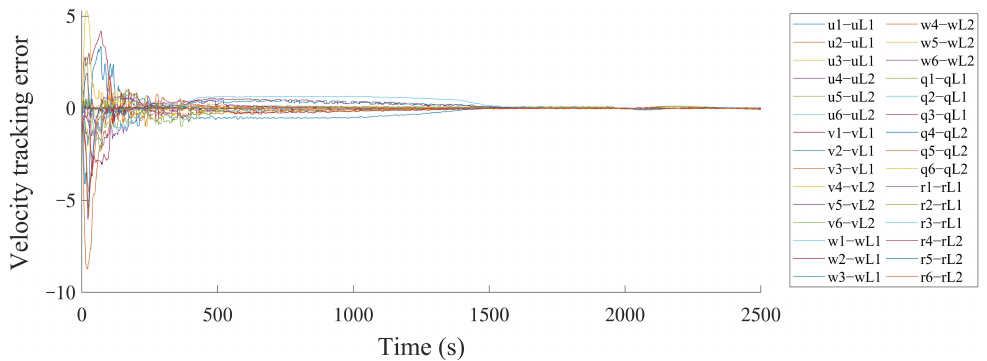
Figure 13. The position tracking errors of a multiple stochastic AUV system in a contrast simulation.